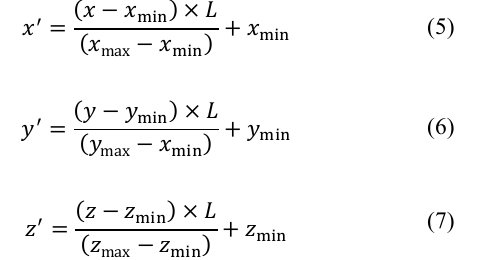
Figure 6. The joint positions of (a). Depth image (b). Body parts (c). 3D joint proposals